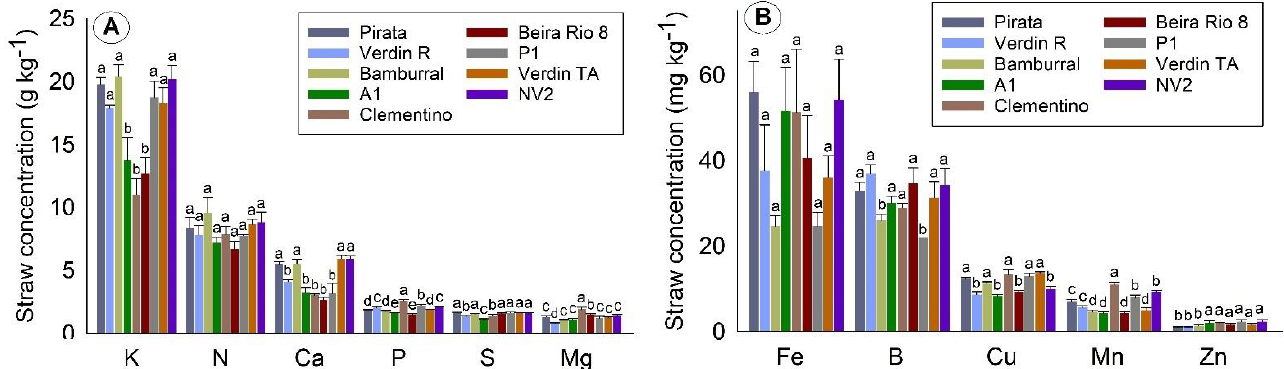
Figure 3. Concentration of macronutrients ( A ) and micronutrients ( B ) in the straw of nine Coffea canephora genotypes. São Mateus, state of Espírito Santo — Brazil. Means followed by the same letter for each nutrient do not differ by the Skott – Knot test at 5% probability.